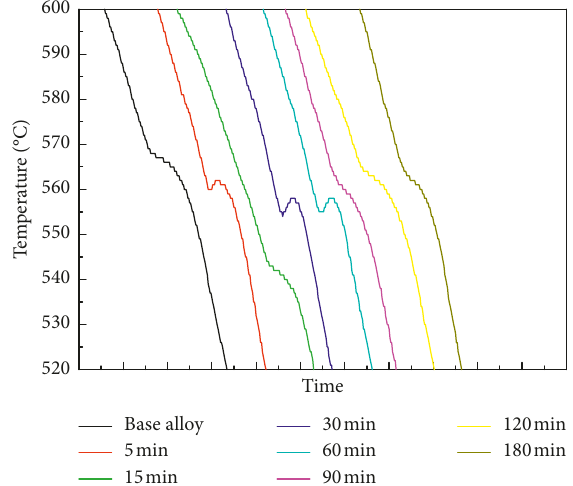
Figure 4: Cooling curves measured from the melt being held for a varying periods of time after combined additions of (Sr +Yb).